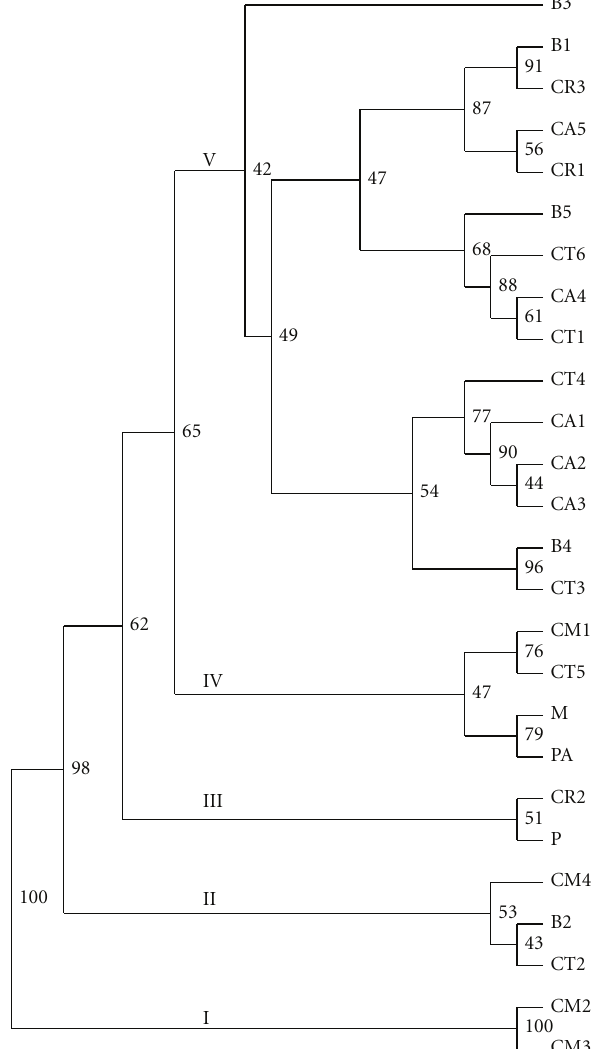
Figure 2: UPGMA phenogram for the 26 co ff ee populations based on Nei’s standard genetic distance. Numbers in front of the branches are bootstrap values.